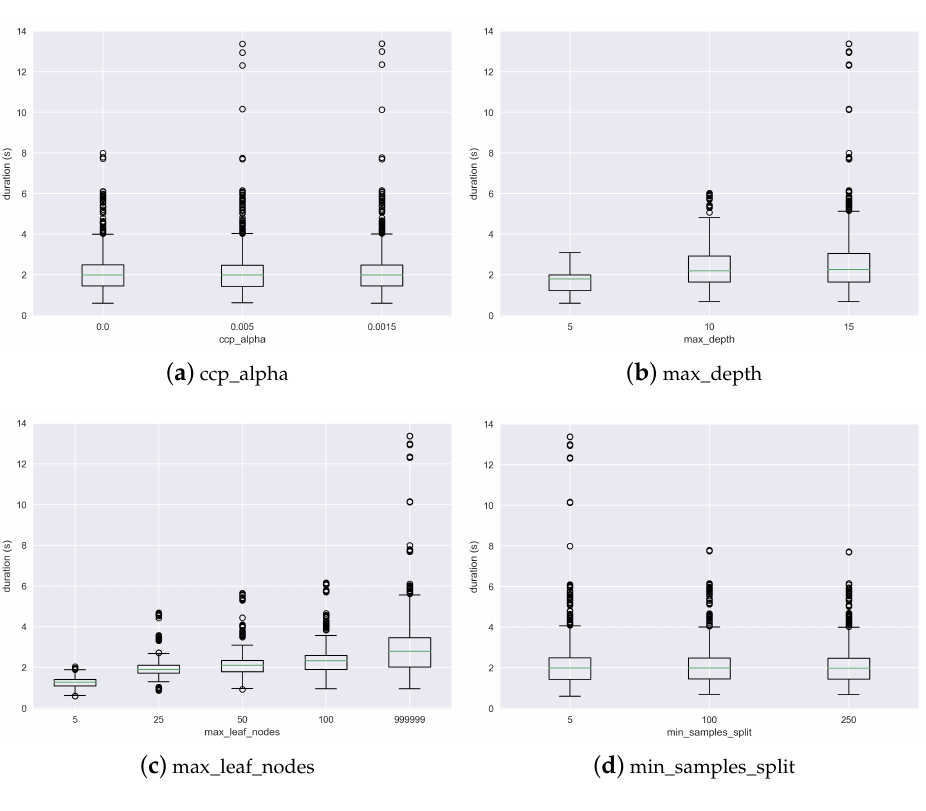
Figure 7. Distribution of the training time for each of the different values set in each of the four hyperparameters tested in the Decision Tree algorithm: ccp_alpha, max_depth, max_leaf_nodes and